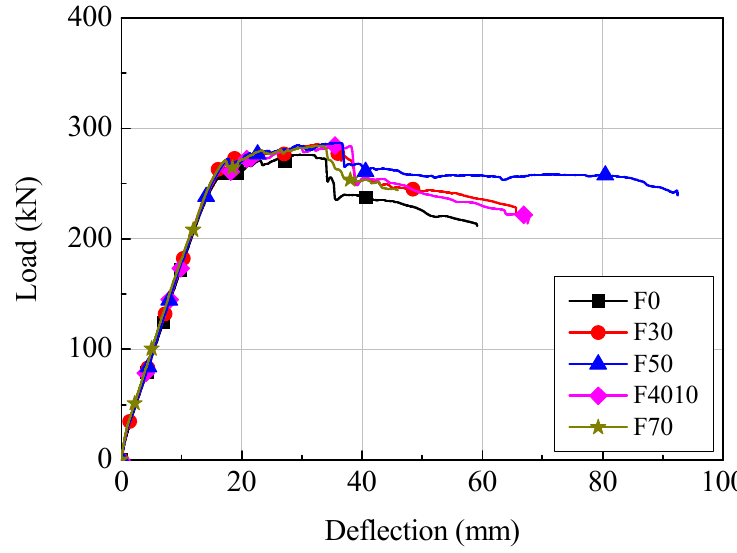
Figure 5. Load-deflection relationships of F series. Figure 5. Load ‐ deflection relationships of F series. Flexural cracks of the F series specimens were generated at loads of 24.3 to 32.3 kN; the deflection was 0.46 to 1.04 mm. The tensile reinforcements reached yield strain at 216.8 to 241.5 kN, and the displacement was 12.5 to 14.1 mm. The load and deflection at the maximum stress were 276.2 to 286.7 kN and 29.7 to 36.0 mm, respectively. In the cases of the F series, the stress of all the specimens, except the F50 specimen, significantly decreased (about 10% or more) after the maximum stress. This may be because of the crushing of the concrete that happened at the compressive